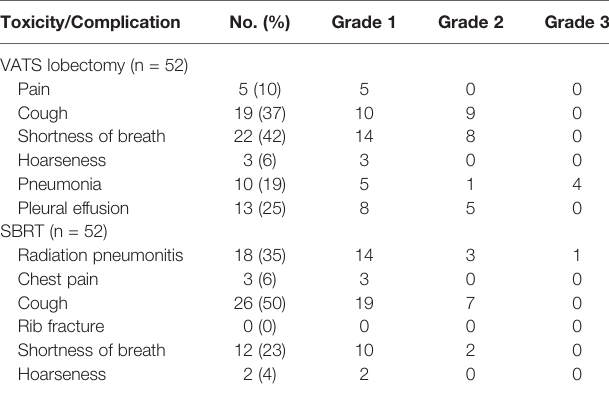
TABLE 3 | Complications after surgery and